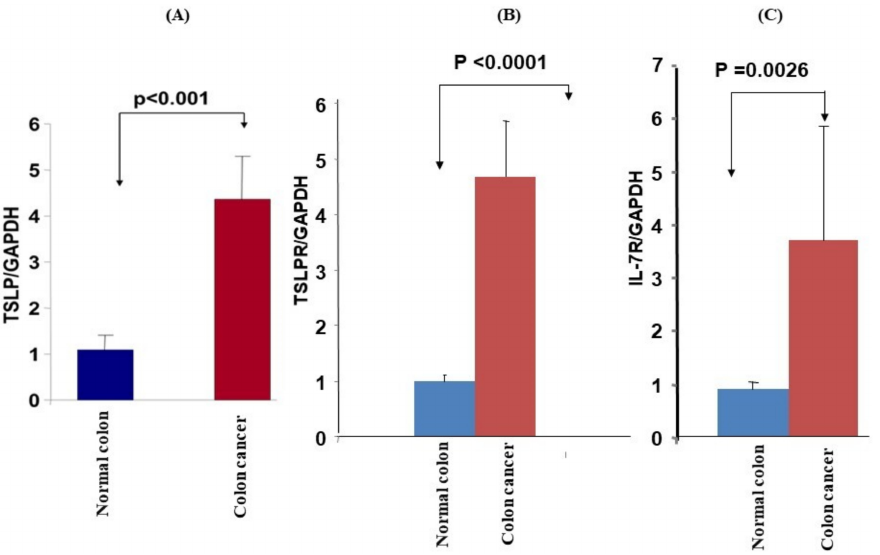
Figure 1. qRT-PCR analyses of TSLP, TSLPR, and IL-7R expressions in matching normal and colon cancer tissues. mRNA expressions of ( A ) TSLP, ( B ) TSLPR, and ( C ) IL-7R in colon cancer tissues when compared to normal colon tissues. The expression levels were normalized to GAPDH reference